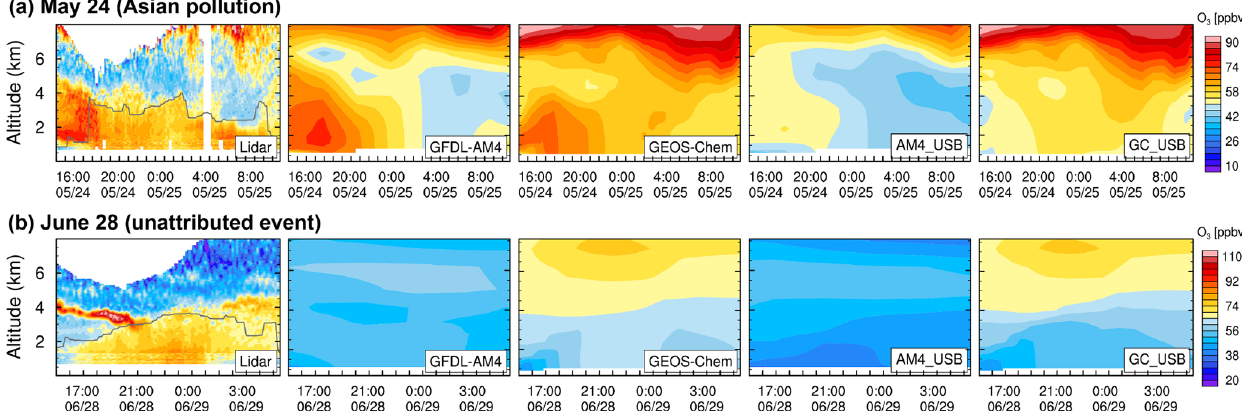
Figure 14. Same as Fig. 8 but for (a) the Asian pollution event on 24 May and (b) the unattributed pollution event on 28 June 2017 (UTC).